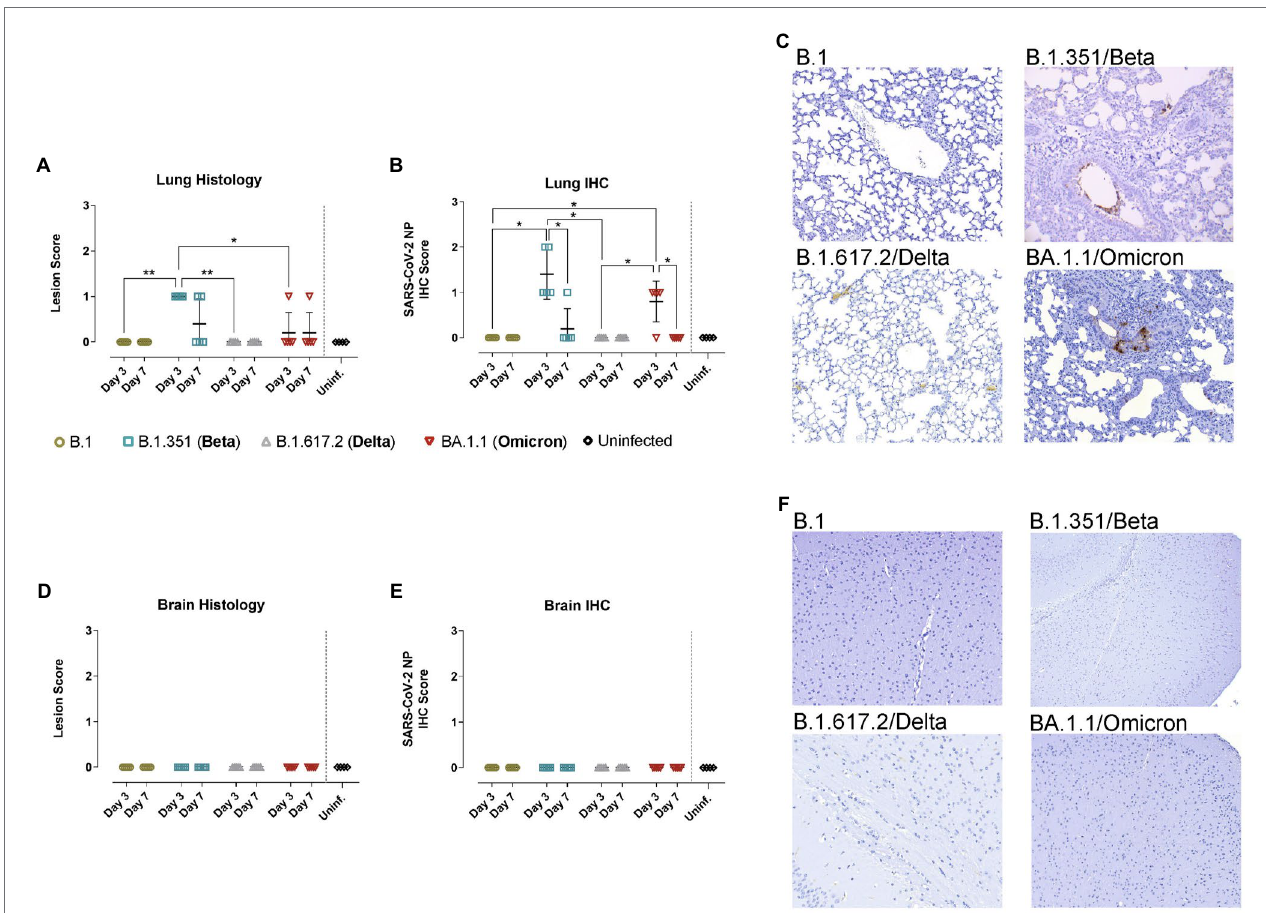
FIGURE 4 | Histopathological and immunohistochemical analyses of lungs and brains from hACE2- mice. WT mice were inoculated with SARS-CoV-2 variants: B.1 (gold, n = 10), B.1.351/Beta (blue, n = 10), B.1.617.2/Delta (grey, n = 10), BA.1.1/Omicron (red, n = 10) or uninfected (black, n = 4). Animals were euthanized at 3 dpi ( n = 5) and 7 dpi ( n = 5). (A) Lung histopathological scoring of broncho-interstitial pneumonia in WT mice. (B) SARS-CoV-2 IHC scoring in lungs of WT mice. (C) Lung IHC from a B.1-, B.1.315/Beta-, B.1.617.2-, and BA.1.1/Omicron-infected WT mouse at 3 dpi. (D) Brain histopathological scoring of non-suppurative meningoencephalitis in WT mice. (E) SARS-CoV-2 IHC scoring in the brain of WT mice. (F) Brain IHC from a B.1-, B.1.315/Beta-, B.1.617.2-, and BA.1.1/Omicron- infected WT mouse at 3 dpi. All immunohistochemical slides were hematoxylin counterstained. Lesion scoring: 0 – no lesion, 1 – mild lesion, 2 – moderate lesion, 3 – severe lesion. IHC scoring: 0 – no antigen, 1 – low and multifocal antigen, 2 – moderate and multifocal antigen, 3 – high and diffuse antigen. Statistical differences were identified using an Independence Asymptotic Generalized Pearson Chi-Squared Test for ordinal data (* p < 0.05; ** p <